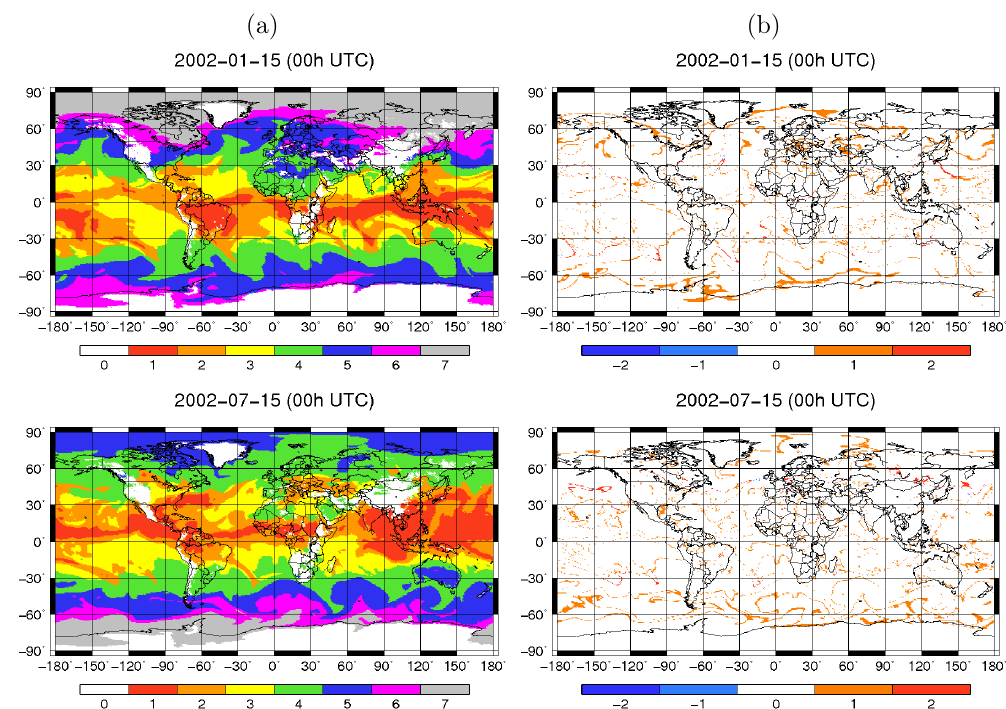
Figure 11. (a) Seven-cluster supervised classification with EM-VII for 2002; (b) cluster index difference between supervised and unsuper- vised